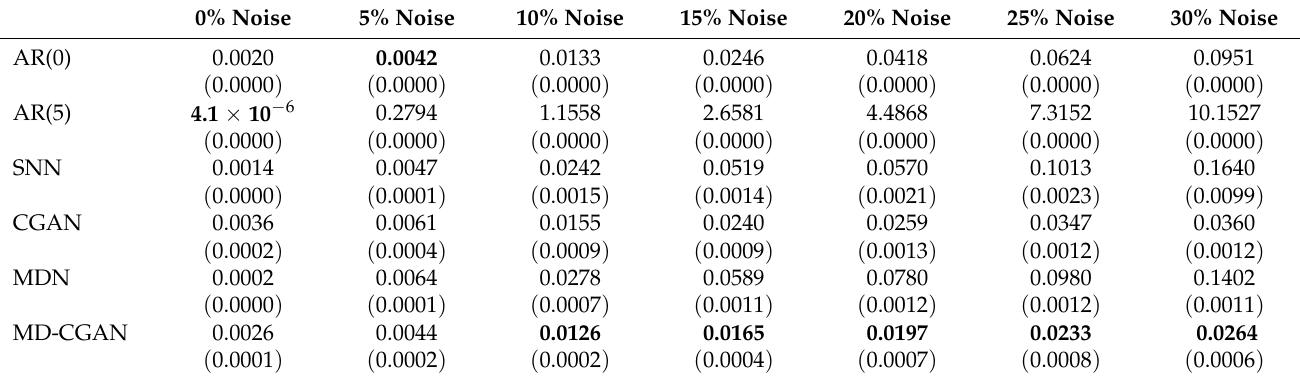
Figure 4. Comparative MSE plots with increasing test set noise perturbation. We note that the GAN-based methods, particularly MD-CGAN, perform consistently even as noise levels increase. Table 1. Mackey-Glass data: MSE variation with added noise level, with standard deviations in